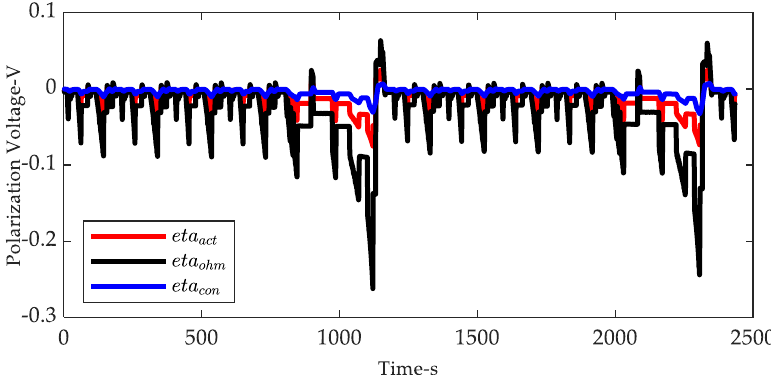
Figure 16. SOC curve based on ampere-hour integral method under the NEDC condition.